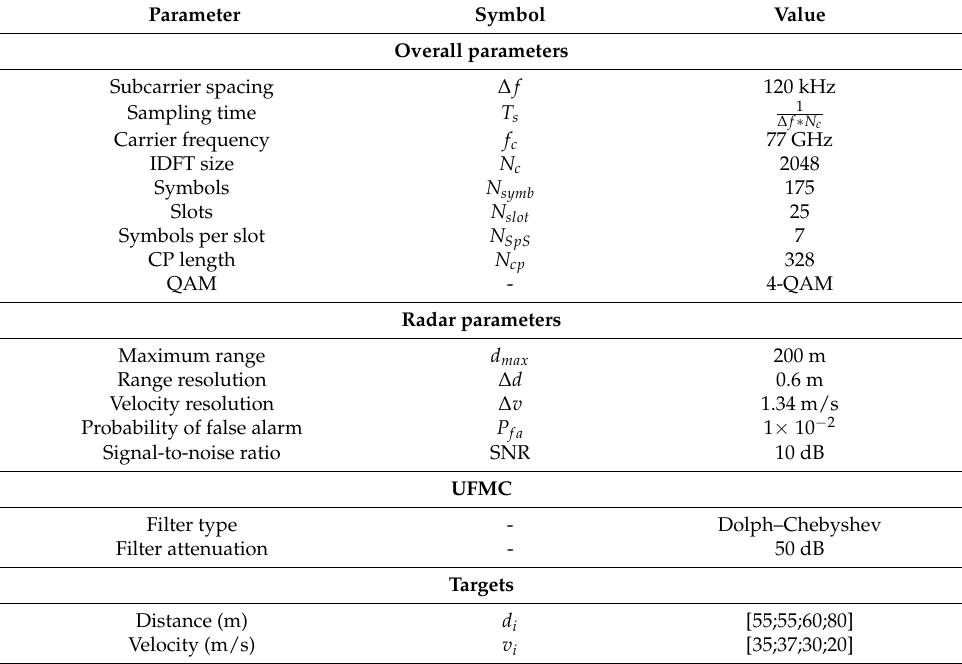
Table 1. Simulation parameters. IDFT, inverse discrete Fourier transform; CP, cyclic prefix; QAM, quadrature amplitude